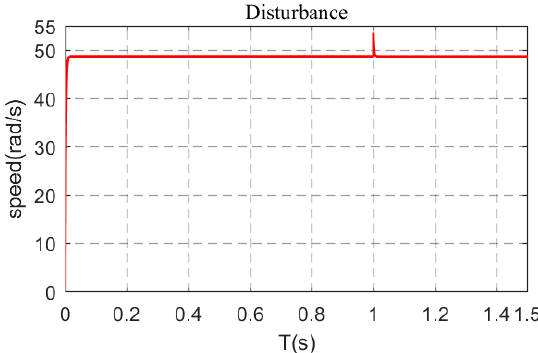
Figure 14. Results of speed response in the case of sudden disturbance.